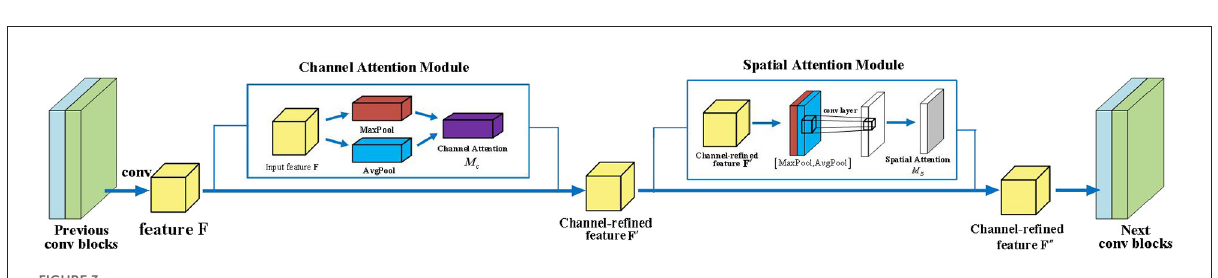
FIGURE3 The model of convolutional block attention module